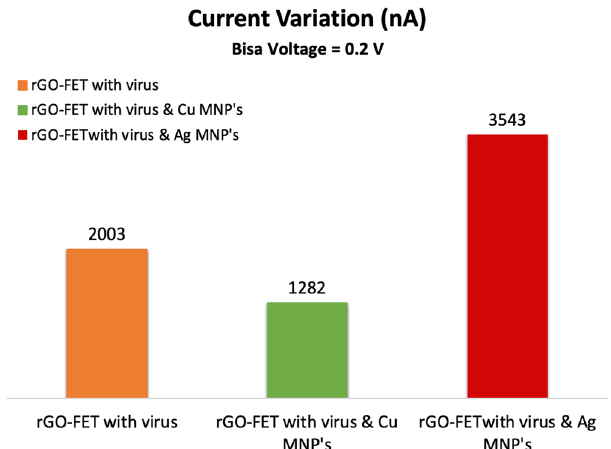
Figure 13. Current variation of the sensor due to the addition of the target molecule (COVID-19 spike antigen). Produced by Excel based on the data generated from QuantumATK software.